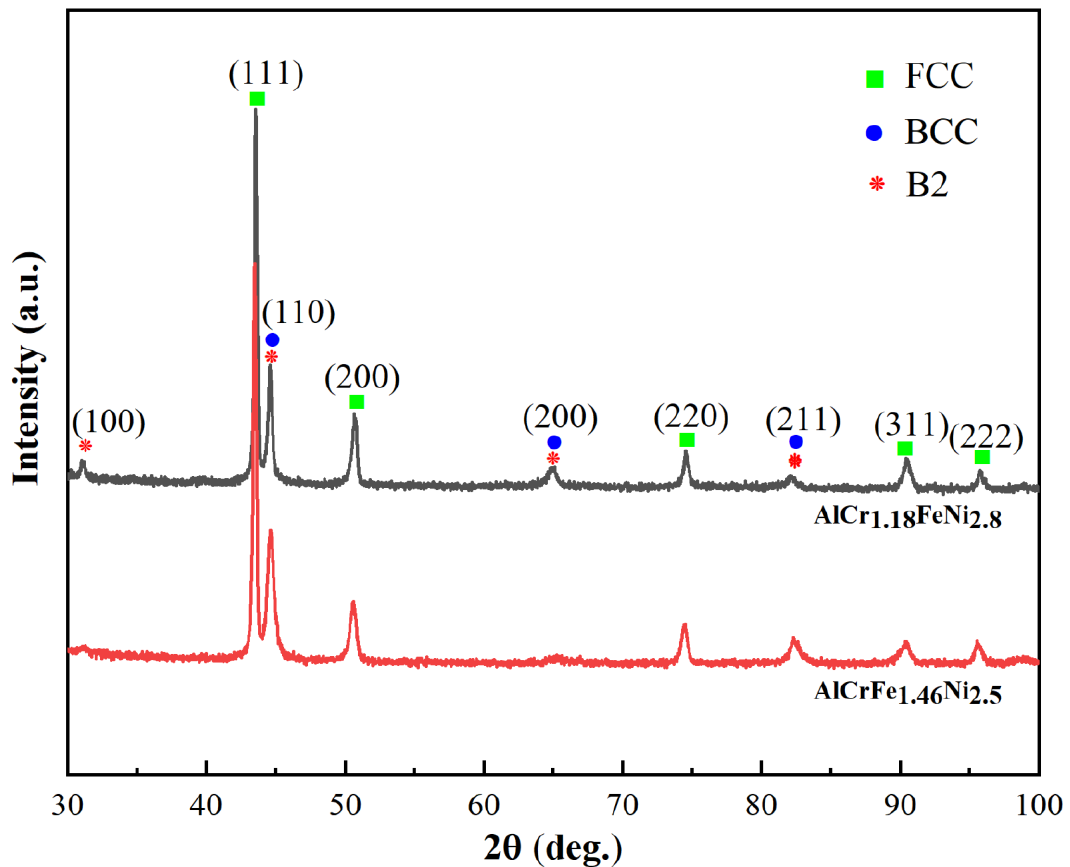
Figure 2. XRD patterns of the AlCr 1.18 FeNi 2.8 and AlCrFe 1.46 Ni 2.5 alloys.